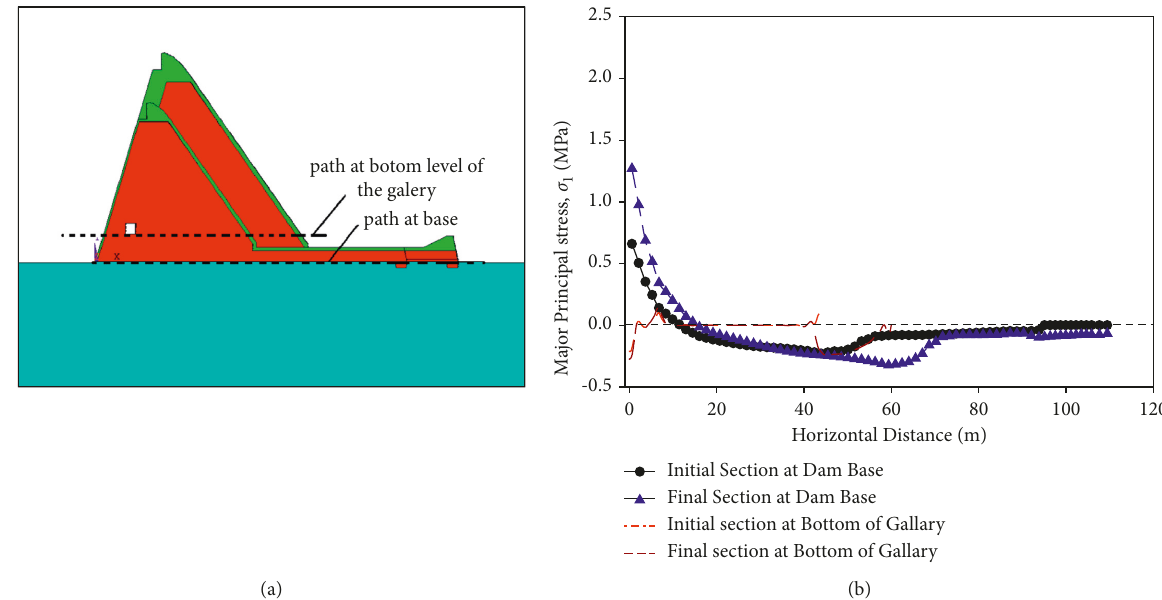
Figure 9: Maximum principal stress distribution as a function of radial distance: (a) location where stresses were taken and (b) for initial and final section at the base of the dam